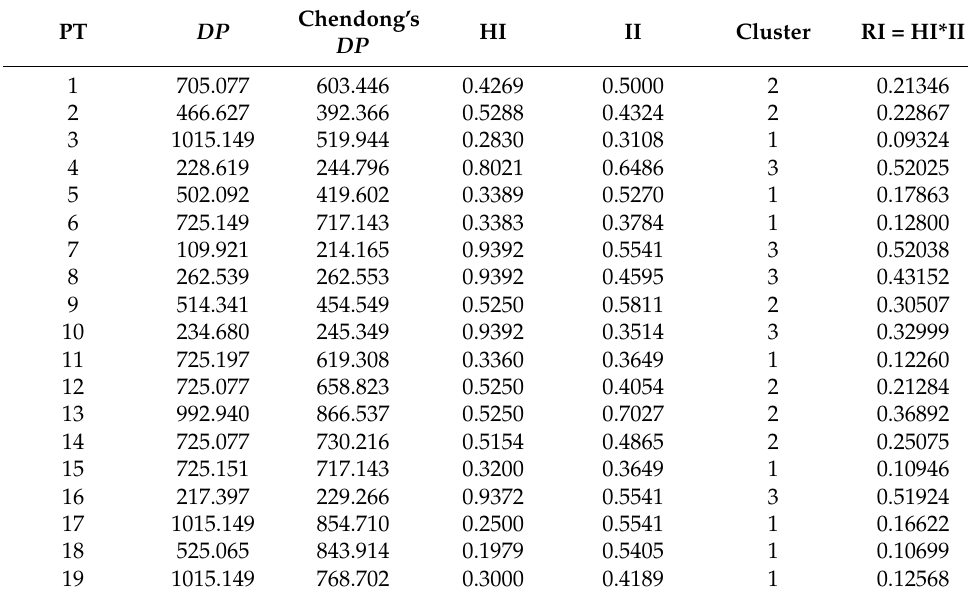
Table 4. Transformers fleet assessment